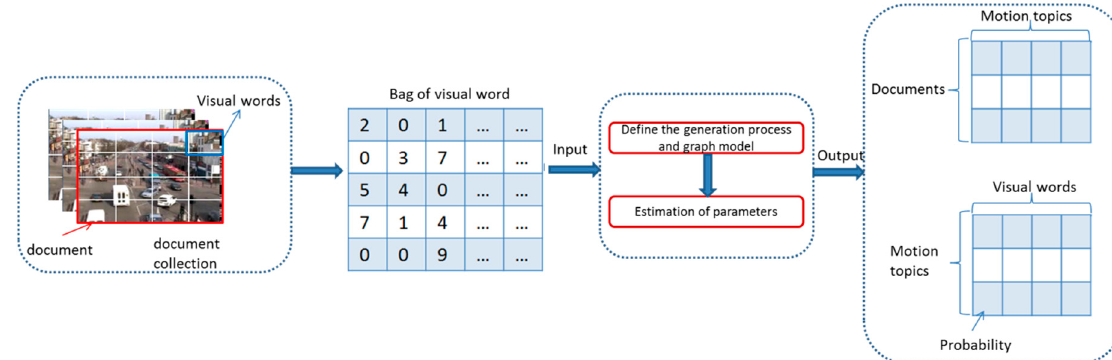
Figure 1. Diagram of video topic modeling.